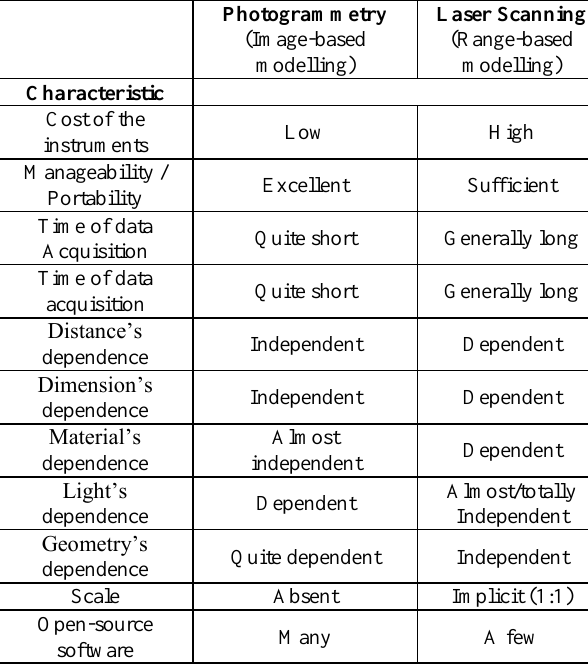
Table 1. Synthesis of photogrammetry and laser scanning techniques and characteristics (Gonizzi Barsanti et al., 2013)